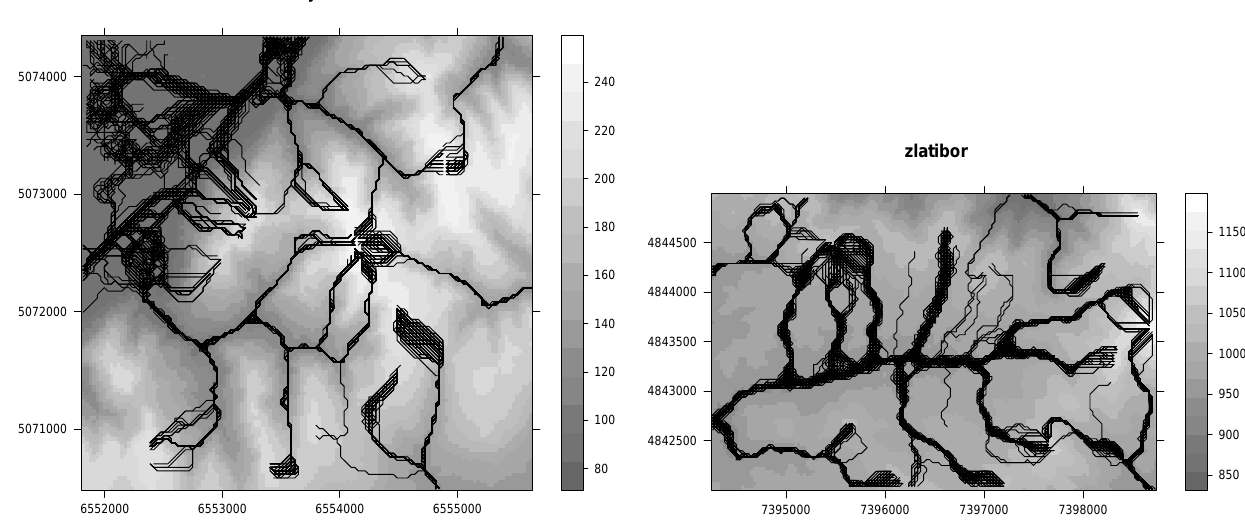
Fig. 5. 100 realizations of stream network overlaid on top of each other: left: Baranja hill case study; right: Zlatibor case study. The greyscale legends indicates elevations in meters.